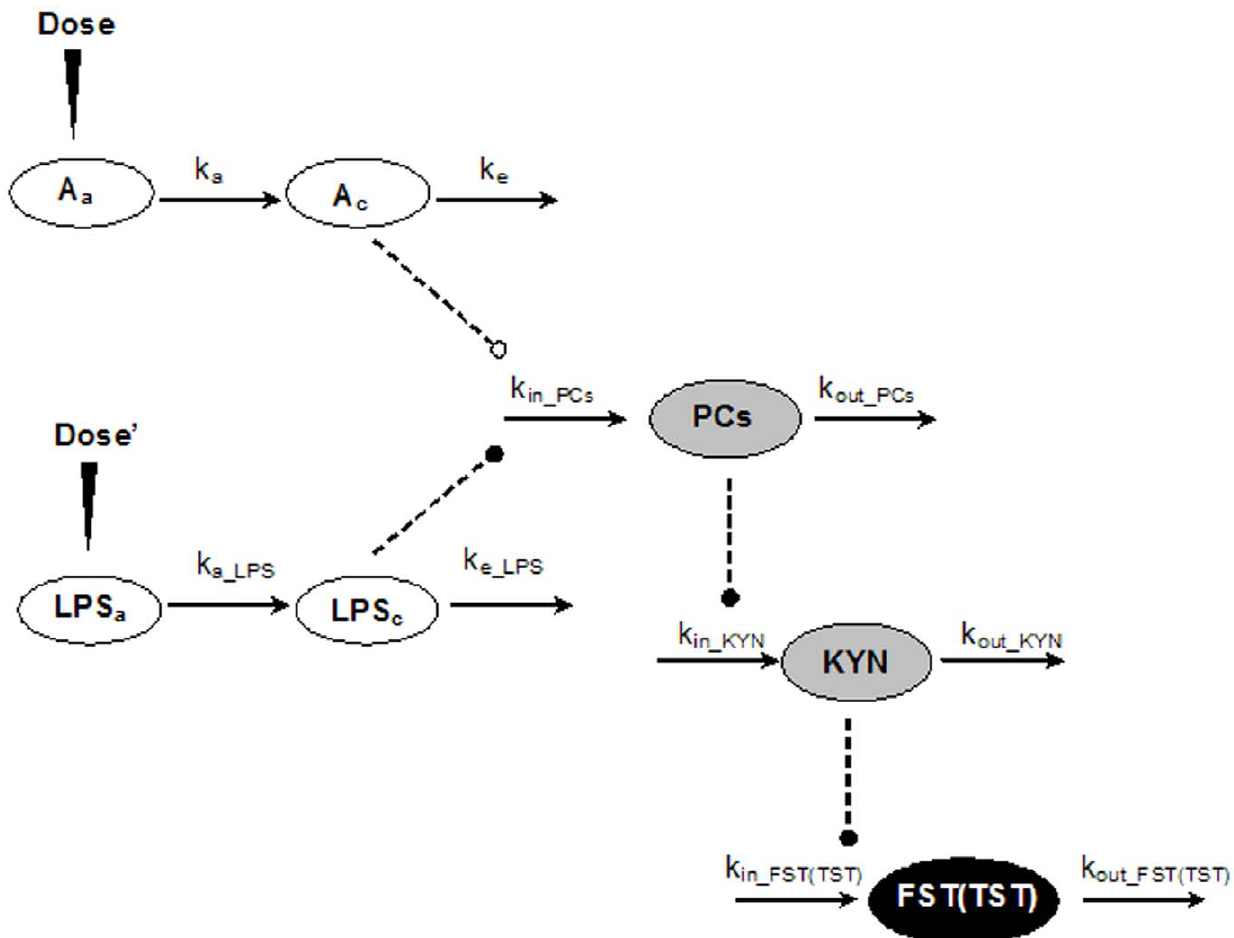
Figure 1. The schematic PK-PD model of the AZI intervention on the LPS -induced depressive-like behavior. Parameters and symbols were described in the text. Solid Lines with arrows indicated the disposition and turnover of the AZI, LPS, PCs, KYN and depressive-like behavior. Dashed lines with black dot meant the stimulatory effect being exerted by the connected factors. Dashed lines with white dot meant the inhibitory effect being exerted by the AZI. Long closed triangle symbols denoted the administration site for the AZI and LPS, respectively.